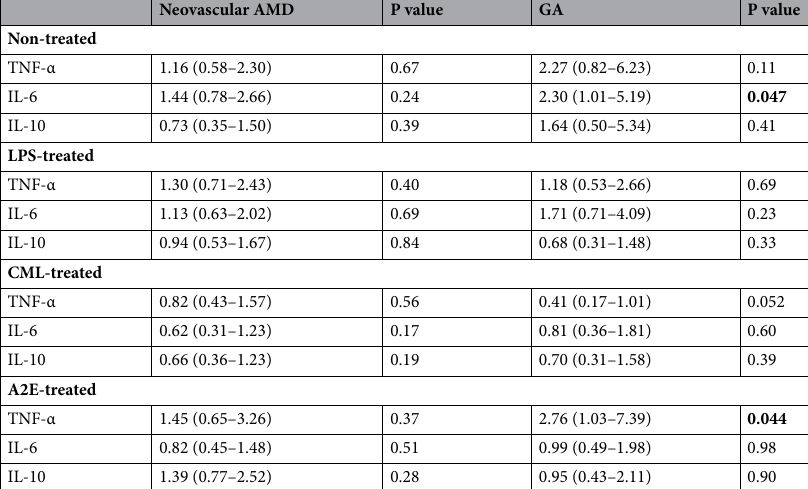
Table 4. Fold increase of cytokine expression in patients with neovascular AMD and geographic atrophy (GA) as compared controls for different stimulation conditions. Data are presented as estimated odds ratio adjusted for age, sex, and neutrophil-to-lymphocyte ratio per incremental increase in Z-score of cytokine expression with 95% confidence intervals. Reference group were healthy controls. Bold values indiactes statistical significance at p < 0.05 level. AMD age-related macular degeneration, GA geographic atrophy, LPS lipopolysaccharide, CML Nε-carboxymethyllysine, A2E N -retinyl- N -retinylidene ethanolamine, TNF -α tumour necrosis factor α, IL